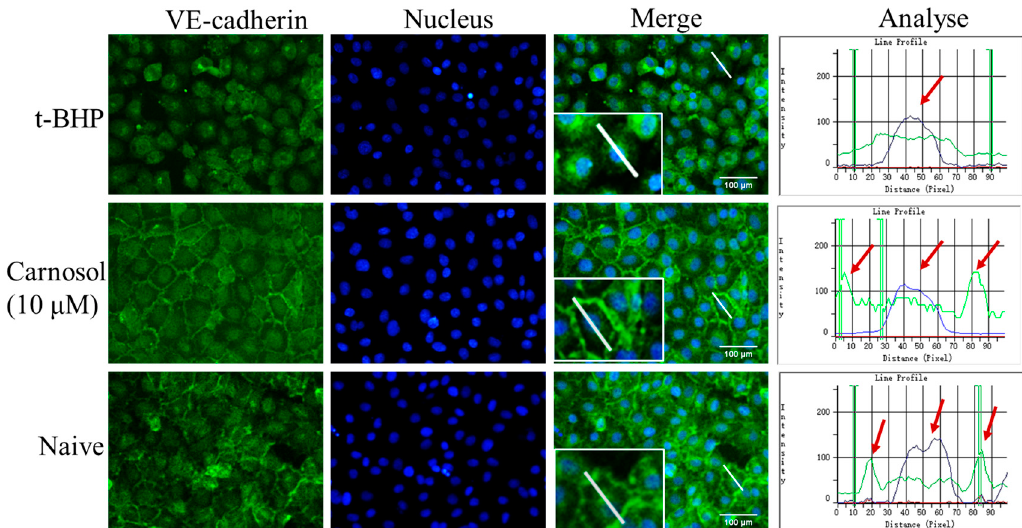
Figure 4. Immunofluorescence staining of VE-cadherin at 20× magnification. VE-cadherin shows a green line on the cell membranes. We continued to enlarge twice in the lower right corner of the merge images. The last row graphs show the relative intensity profiles of fluorescent signal intensities of VE-cadherin (green) and nucleu (blue) along the white line scans depicted in the immunofluorescent images. The X -axis indicates the distance of the line and the Y -axis represents the fluorescence intensity. The red arrows indicate the location of the peak.